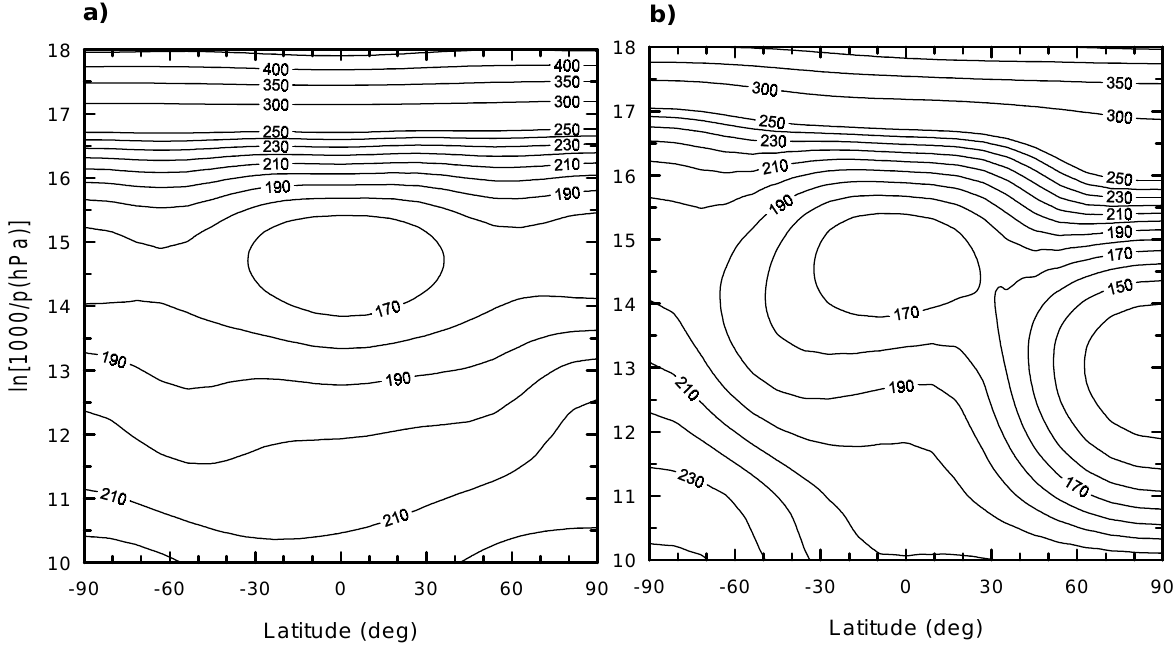
Fig. 2. Latitude-height distributions of background temperature in Kelvin in the UMLT region for 16 March ( a ) and 1 July ( b ) from the MSISE-90 model (Hedin, 1991).